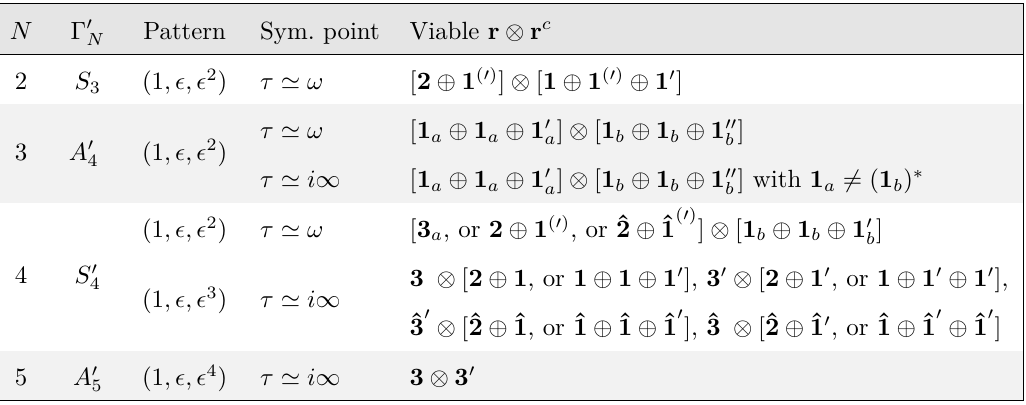
Table 2. Hierarchical mass patterns which can be realised in the vicinity of symmetric points. These patterns are unaffected by the exchange r ↔ r c and may only be viable for certain